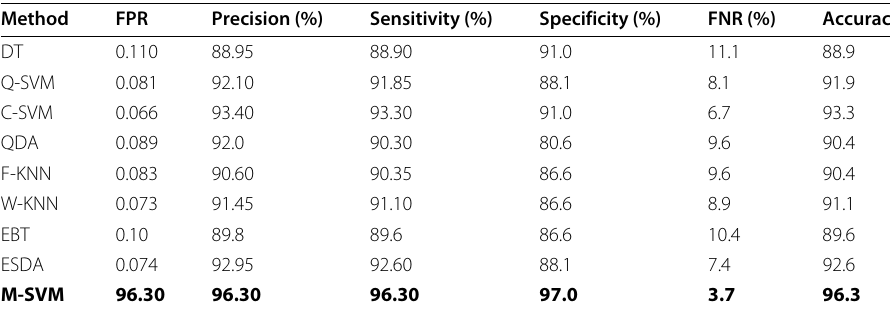
Table 11 Proposed classification results for grapes leaf